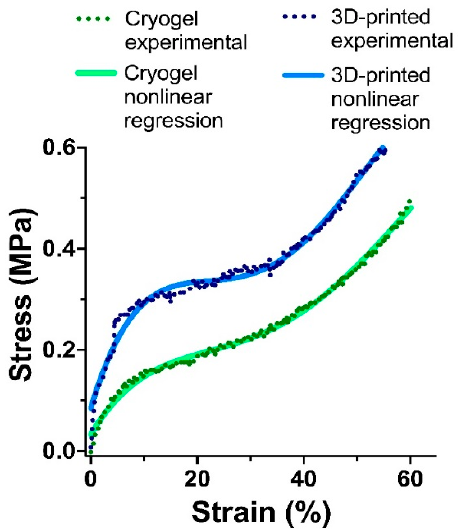
Figure 12. Strain–stress test curves for cryogelated and 3D-printed matrices. The compression stress was applied with initial force 0.1 N. The speed of compression was 2 mm/min. The data on the graph are representative of 3 measurements (n = 3).